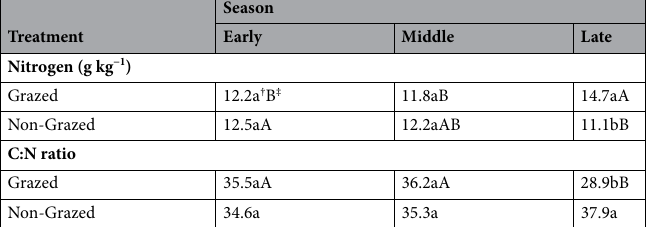
Table 1. Treatment × season interaction on N concentration ( P < 0.001; SE = 0.64) and C:N ratio ( P < 0.01; SE = 1.93) of RP roots and rhizomes collected at three different times of the year. † Different letters within the same column and same response are statistically different at the 5% probability level. ‡ Different letters within the same row are statistically different at the 5% probability level. Early season: 2 May 2018 and 1 May 2019. Middle season: 27 June 2018 and 26 June 2019. Late season: 23 Aug. 2018 and 21 Aug. 2019.